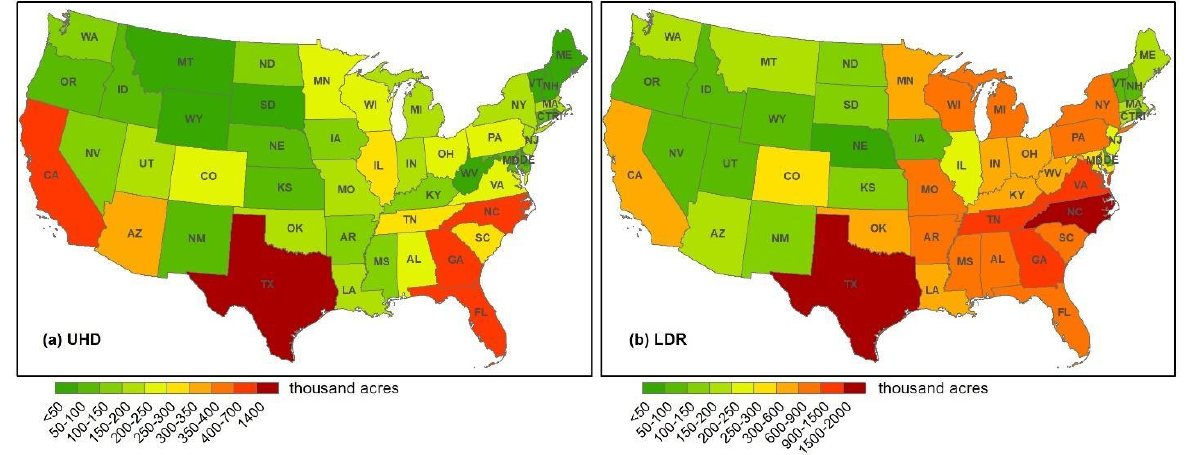
Figure 8. Projected per-state urban and highly developed (UHD) ( a ) and low-density residential (LDR) ( b ) growth by 2040 under the business-as-usual